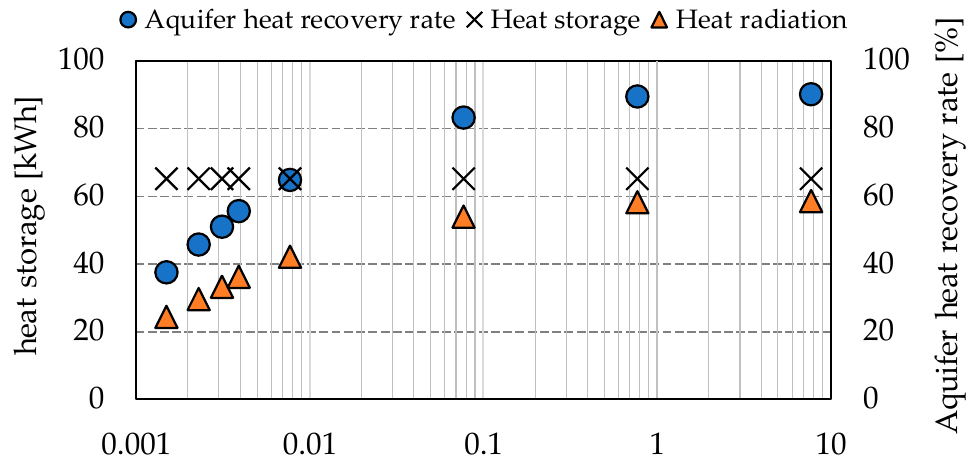
Figure A1. The sensitivity analysis of the model.